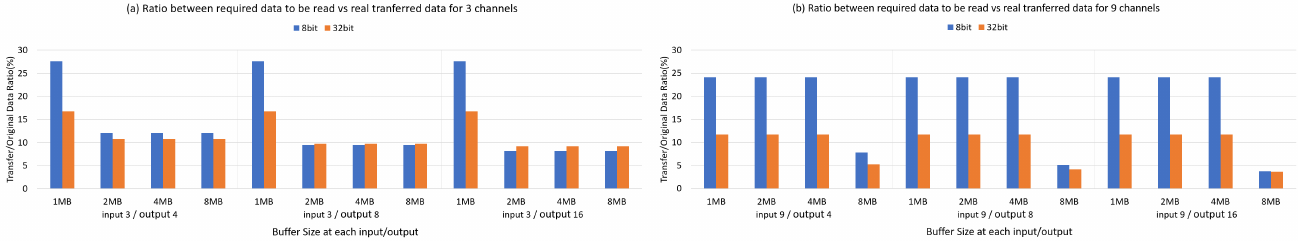
Figure 12. It plots the ratio of actual data transfer to the amount of data required for NN operations according to the precision level with 1 M and 8 M buffers, respectively; ( a ) input3/output (4, 8, 16) and ( b ) input9/output (4, 8,